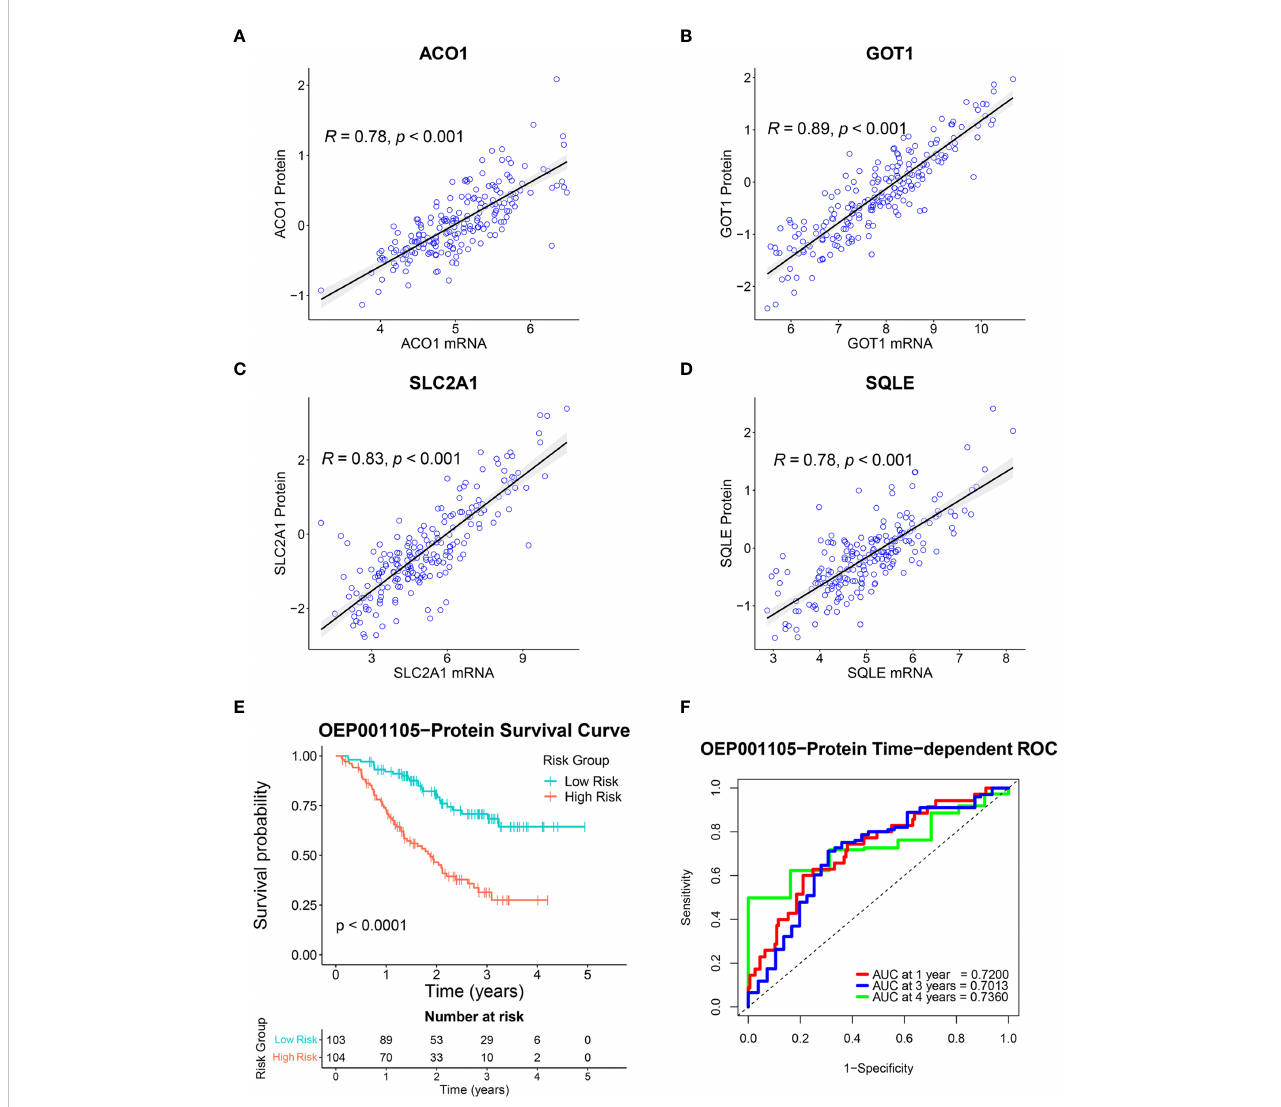
FIGURE 9 Validation of the six-FRG signature based on protein levels in the OEP001105 cohort. (A – D) Scatter plots showing the correlation between mRNA and protein expression levels of ACO1 , GOT1 , SLC2A1 , and SQLE . (E) A Kaplan-Meier curve comparing survival time between patient groups de fi ned on six- FRG signature protein levels. (F) Time-dependent ROC